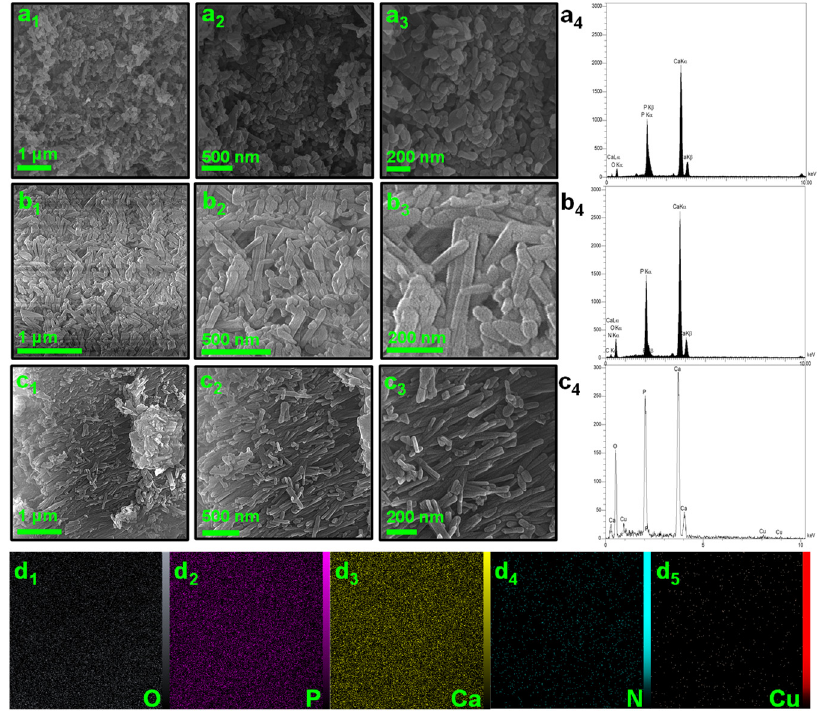
Figure 1. SEM images and corresponding EDS spectra of ( a1 – a4 ) pure HAp, ( b1 – b4 ), THAp, and ( c1 – c4 ) Cu-THAp samples. ( d1 – d5 ) SEM-elemental mapping of Cu-THAp sample. The XRD patterns of the synthesized samples are shown in Figure 2a. The peaks of THAp and Cu-THAp appear in 2 θ of 10.82°, 25.90°, 31.80°, 32.15°, 32.89°, 34.18°, 39.88°, 46.76°, and 49.51°, assignable to the (010), (002), (121), (112), (030), (002), (310), (222), and (123) facets of the hexagonal phase in HAp with P6 3 /m space group (COD No. 96 − 900 − 3549). Adding Cu ions to THAp can lead to an in situ formation of copper phos- phate on the surface. By comparing the simulated XRD pattern of copper phosphate (No. 96-120-0003), appearing some major peaks in the 2 θ of 21.73°, 27.70°, 30.53°, 37.33°, and 41.32° are attributable to the (110), (011), and (012) planes of the Cu 3 (PO 4 ) 2 with the space group P-1 . The FTIR spectra of both THAp and Cu-THAp samples are contained from the HAp’s main functional groups (Figure 2b). Hence, the peaks at 3440, 1034, 604, and 565 cm − 1 can be attributable to OH − , HPO 2 − , and PO 3 − functional groups [33]. In the Cu-THAp sample, there is a peak of about 467 cm − 1 . This peak corresponds to the vibrations of the Cu-O bond on the surface of the Cu-THAp sample.